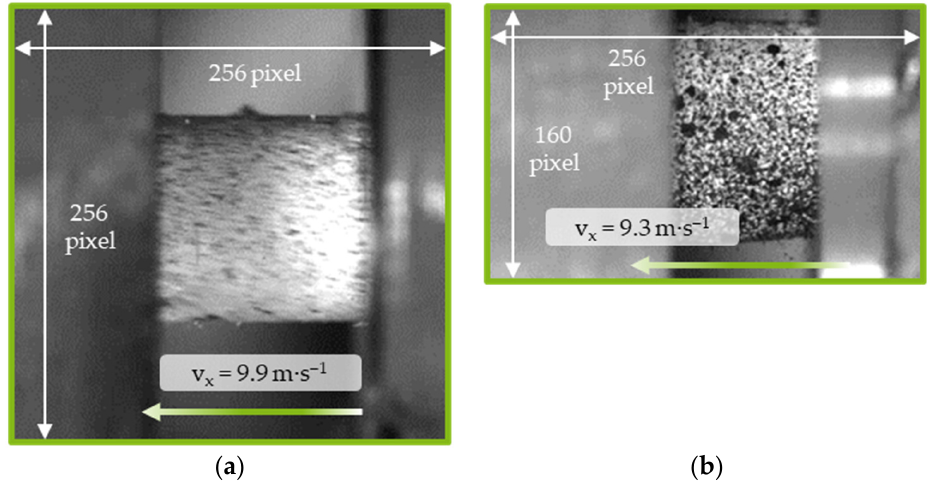
Figure 5. Comparison of high-speed camera parameters with ( a ) motion blur and ( b ) no motion blur occuring.